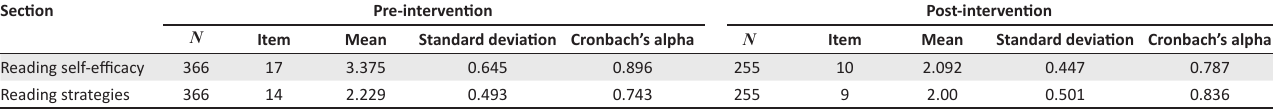
TABLE 3: Questionnaire responses. Section Pre-intervention